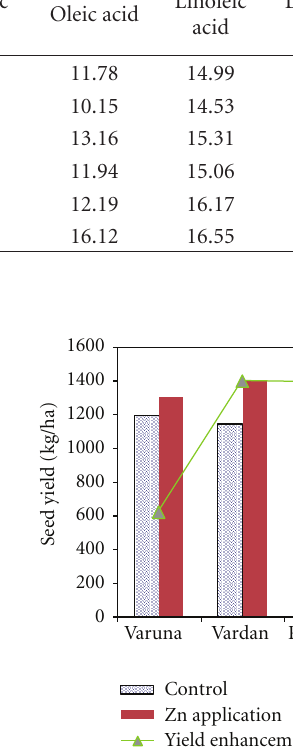
Figure 2: Influence of zinc application on seed yield of di ff erent cultivars of